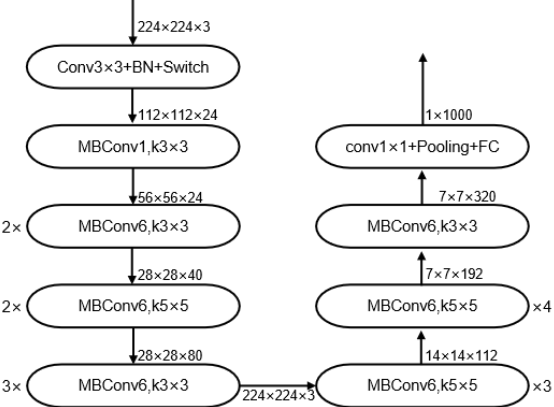
Figure 6. Illustration of the EffecientNet-B0